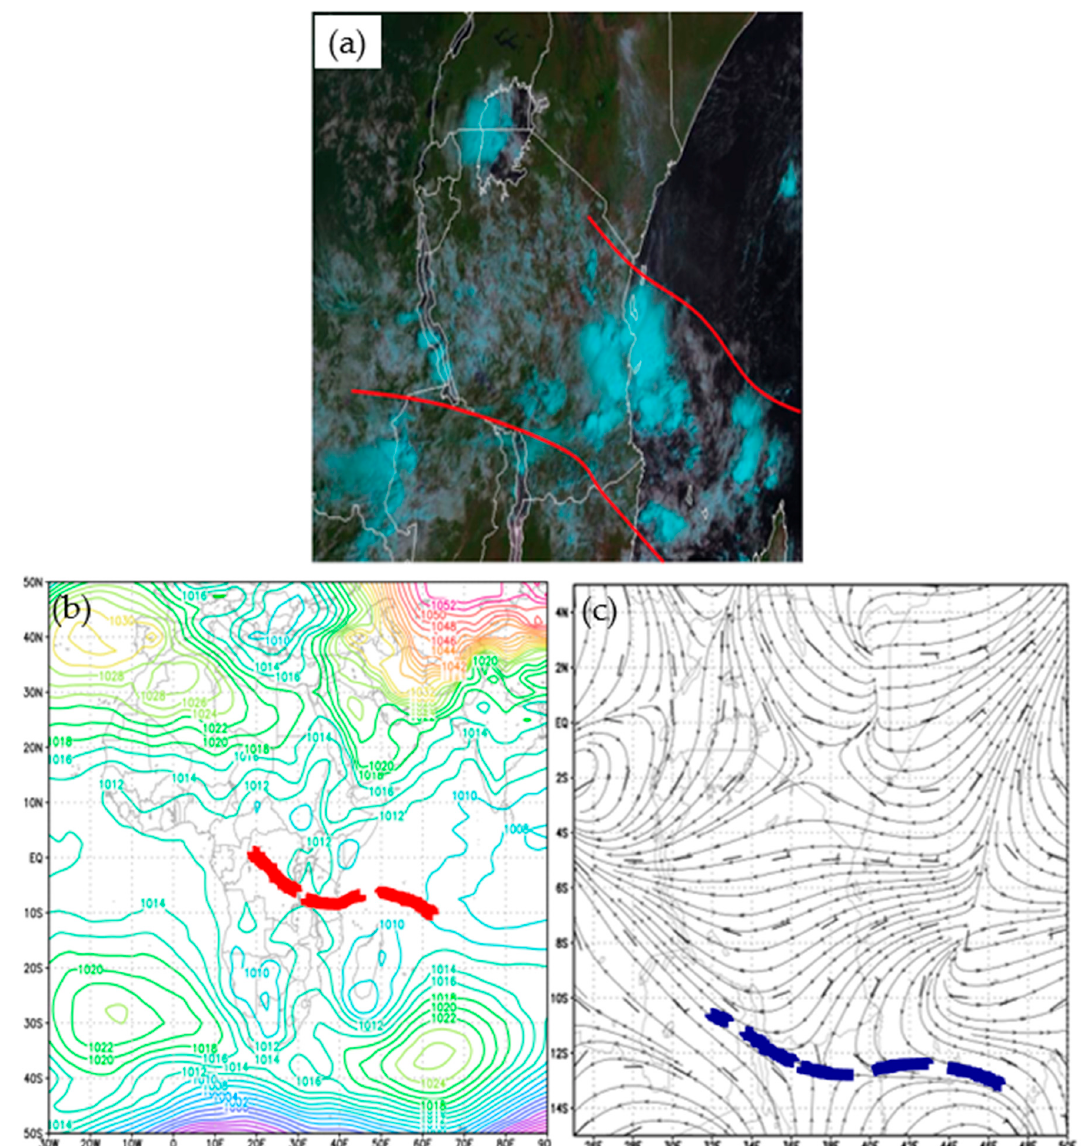
Figure 2. ( a ) Day natural color RGB (VIS0.6 VIS0.8 VIS1.6) satellite imagery of Eastern Africa at 07:12UTC of 21st December 2011 showing cloud development zone (indicated in red) indicating the presence of the inter tropical convergence zone (ITCZ) (Image source: EUMETSAT); ( b ) MSLP pattern on 20–22 December 2011 showing a low-pressure area (red dashed line) over Tanzania; and ( c ) 700 hPa mean wind-flow pattern on 20–22 December 2011 showing the location of the inter tropical convergence zone (blue dashed line) over Tanzania. (Images source: NCEP Reanalysis Data).